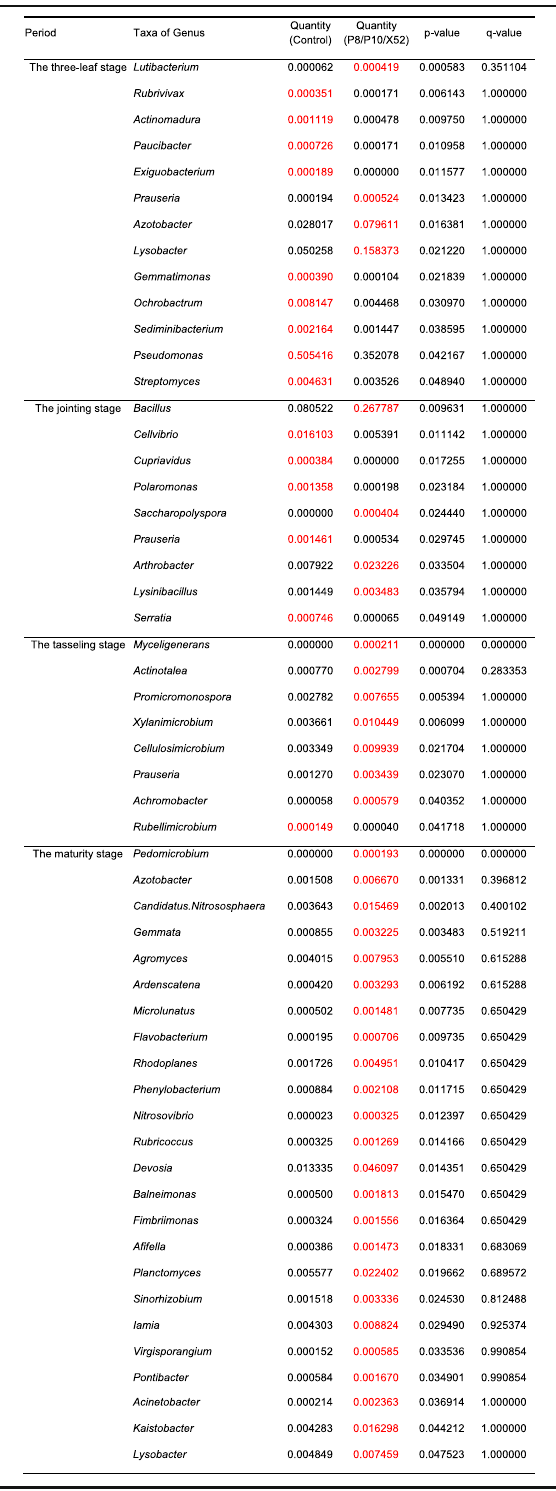
Table 2 The difference in quantity (relatively abundance) of the rhizosphere microbiota of maize at each stage